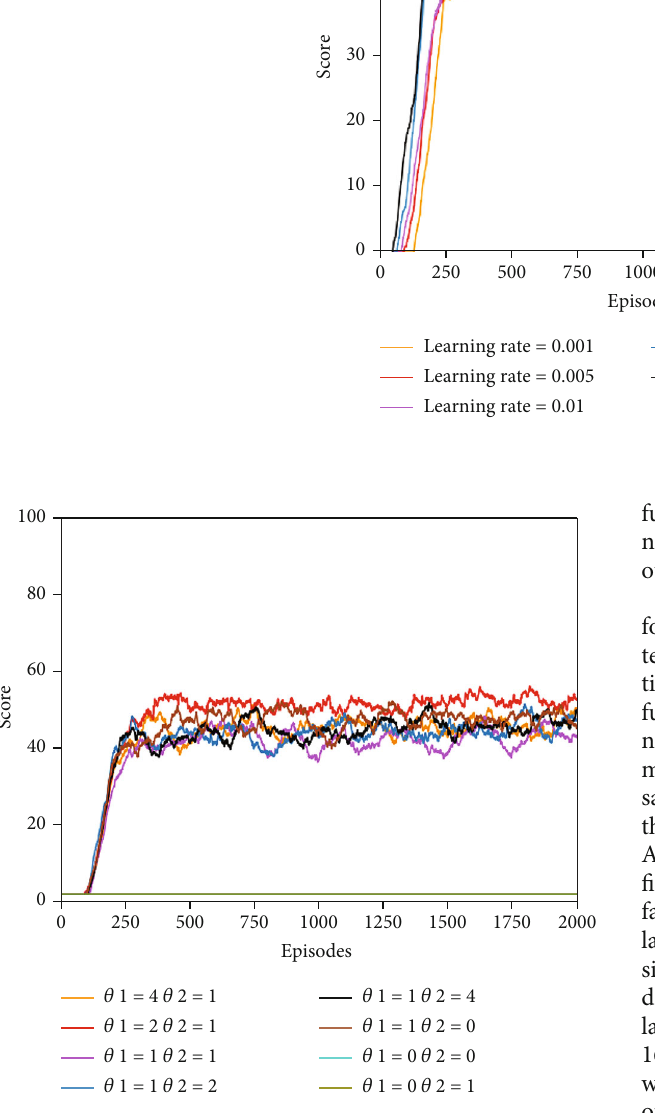
Figure 6: The score with di ff erent reward coe ffi